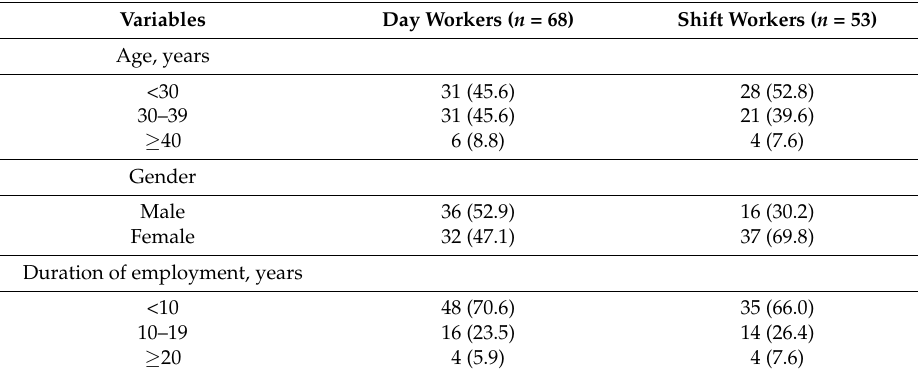
Table 1. Demographic characteristics of the day and shift workers.